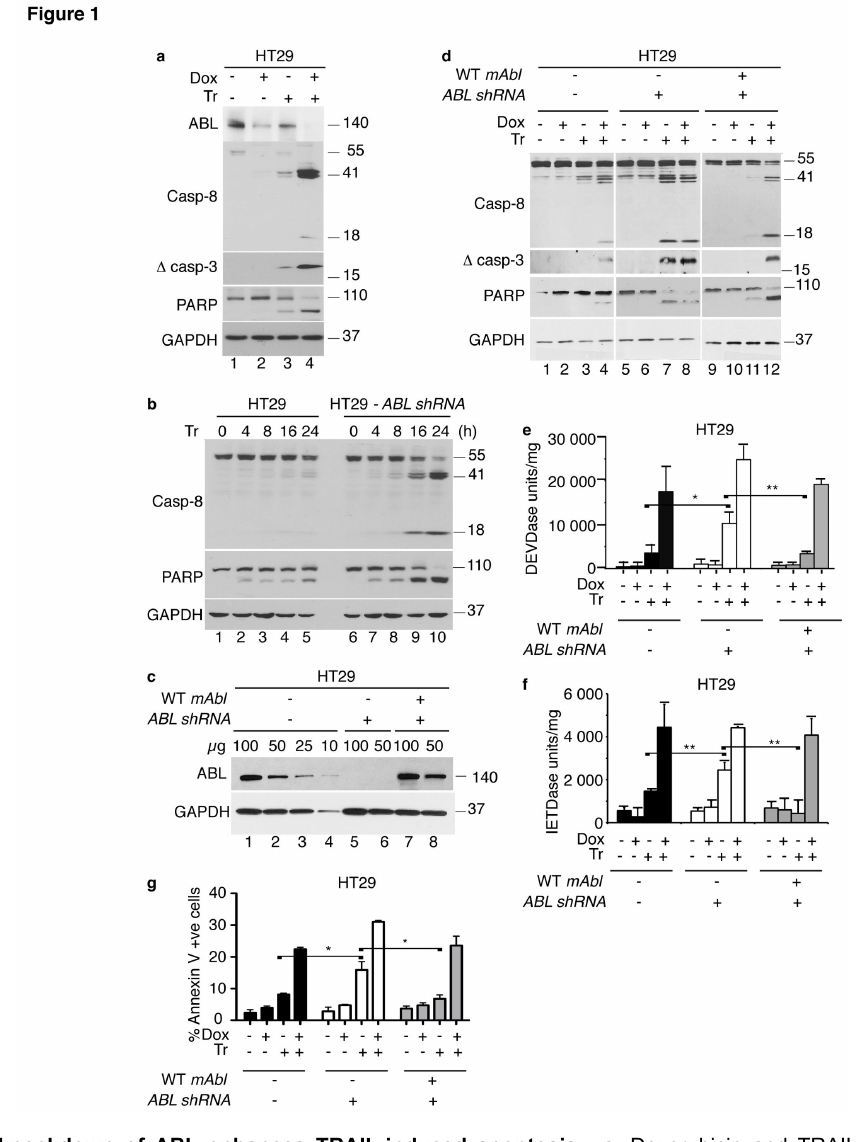
Figure 1. Stable knockdown of ABL enhances TRAIL-induced apoptosis. a. Doxorubicin and TRAIL caused ABL